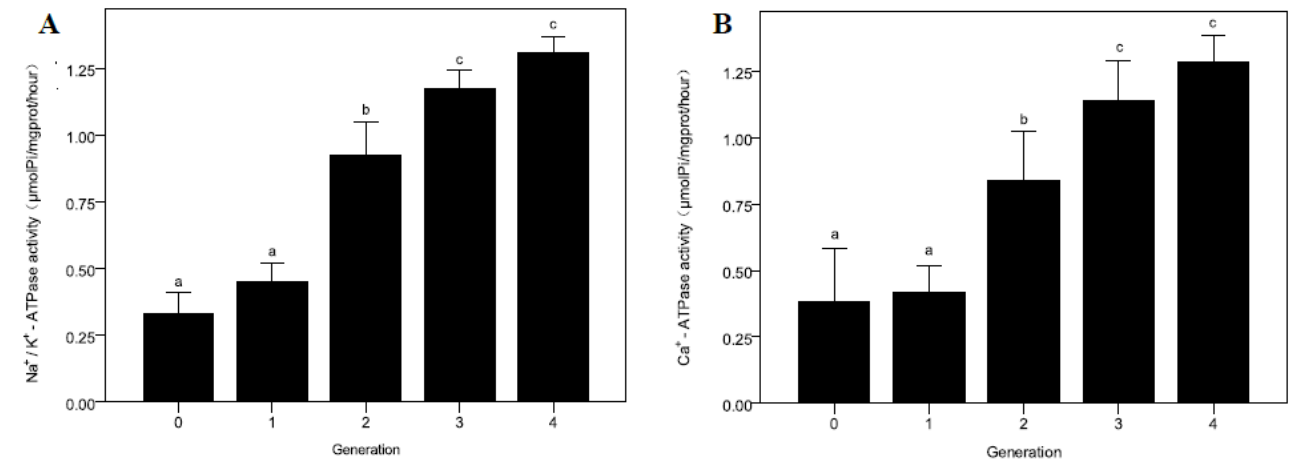
Figure 7. Effect of seawater acidification on ATPase activity (mean ± standard, n = 3) of T. japonicus in five generations. Successive generations were exposed to a lower pH than their parents. ( A ) Na + /K + -ATPase activity. ( B ) Ca 2+ -ATPase activity. Statistical differences among generations ( p < 0.05) are represented by different letters.